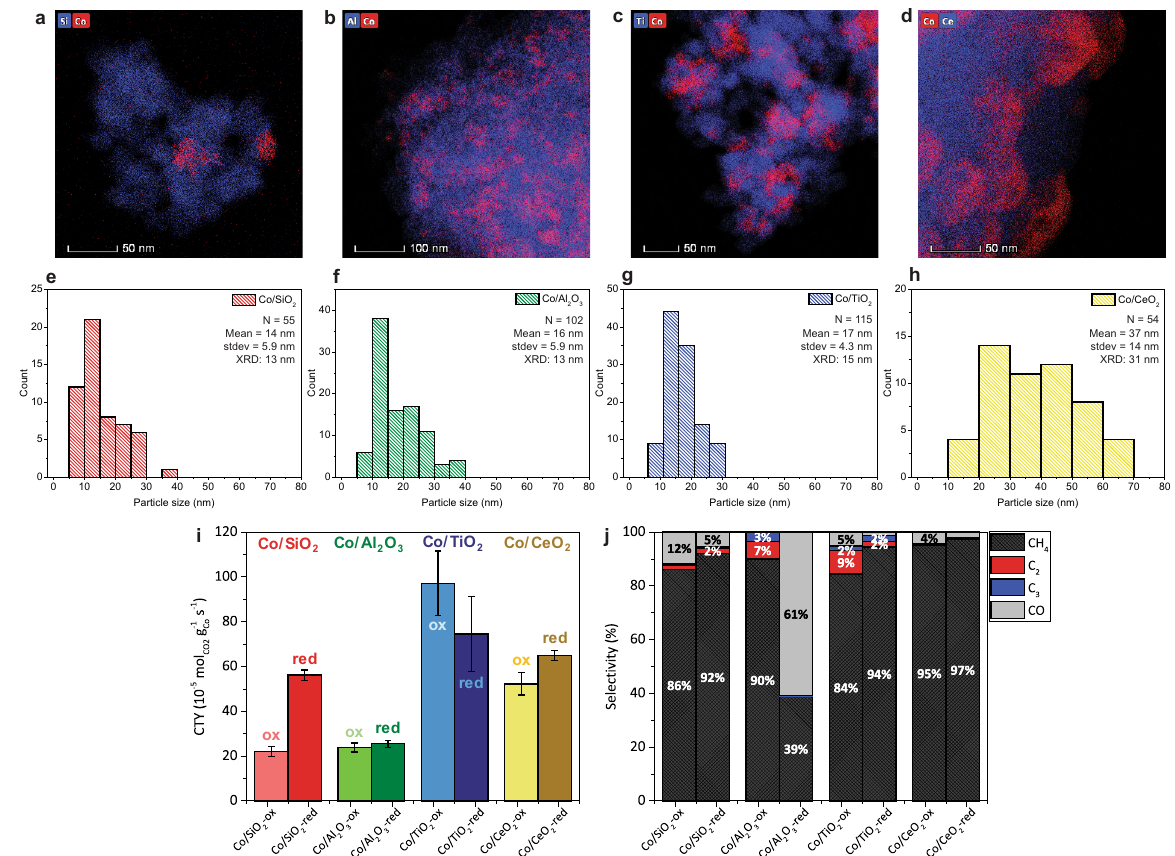
Fig. 1 Cobalt particle size analysis and effect of support and oxidation state on catalytic activity. Energy dispersive X-ray spectroscopy (EDX) elemental mapping of the calcined catalysts (250 °C in N 2 ): a Co/SiO 2 , b Co/Al 2 O 3 , c Co/TiO 2 , and d Co/CeO 2 . Cobalt oxide particle size distributions determined with transmission electron microscopy (TEM), where N denotes the number of particles counted, and average crystallite sizes calculated based on X-ray diffraction (XRD) results for e Co/SiO 2 , f Co/Al 2 O 3 , g Co/TiO 2 , and h Co/CeO 2 . i , j Catalytic activity (cobalt-time-yield (CTY)) and selectivity of cobalt- based catalysts as measured with gas chromatography (GC) over 10 h time-on-stream in CoO (suf fi x: -ox) and metallic Co (suf fi x: -red) state at T = 250 °C, P = 20 bar, H = 3. The automated GC injections were performed every 23 min and the whiskers indicate the standard deviation (stdev) 2 /CO 2 in the 26 data points per (suf fi x: -red) catalysts. Prior to testing, the indicated cobalt oxi- dation states were obtained by heating in 33 vol% H 2 /N 2 at 250 °C for the CoO and 450 °C for the metallic Co catalysts. The oxi- dation state was veri fi ed and monitored with operando Raman micro-spectroscopy experiments (Supplementary Figs. 5 and 6).